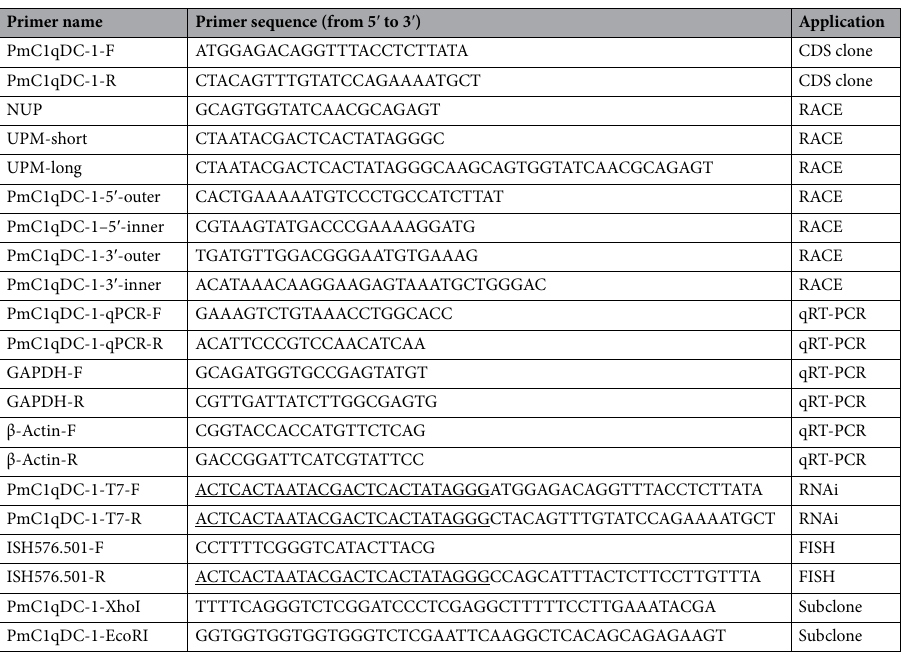
Table 1. Names and sequences of primers used in this study. Note: The sequences underlined are the sequence of the T7